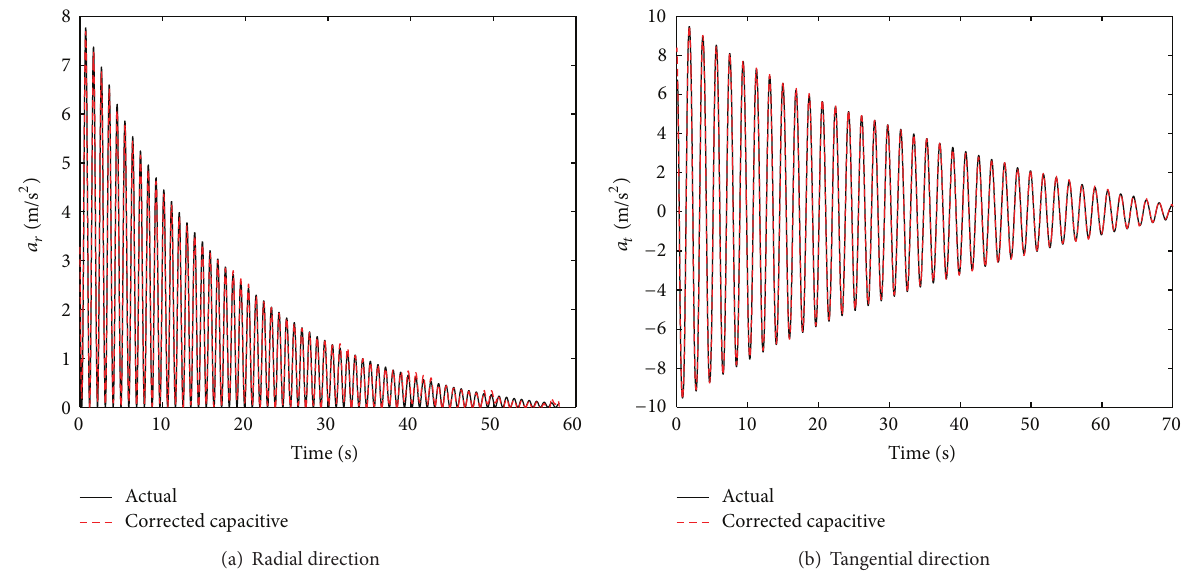
Figure 3: Comparisons between actual accelerations and corrected capacitive